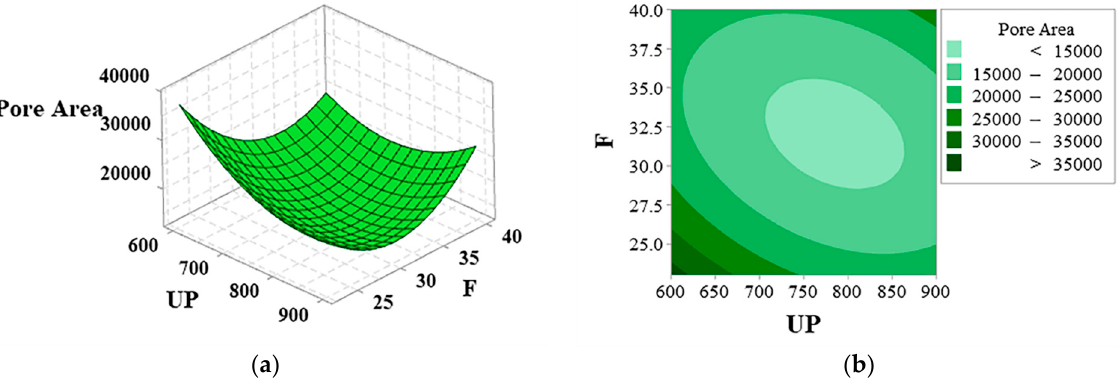
Figure 8. UP and F interaction diagram: ( a ) surface diagram and ( b ) contour diagram. Figure 9a,b present the coating morphologies with and without ultrasonic vibrations